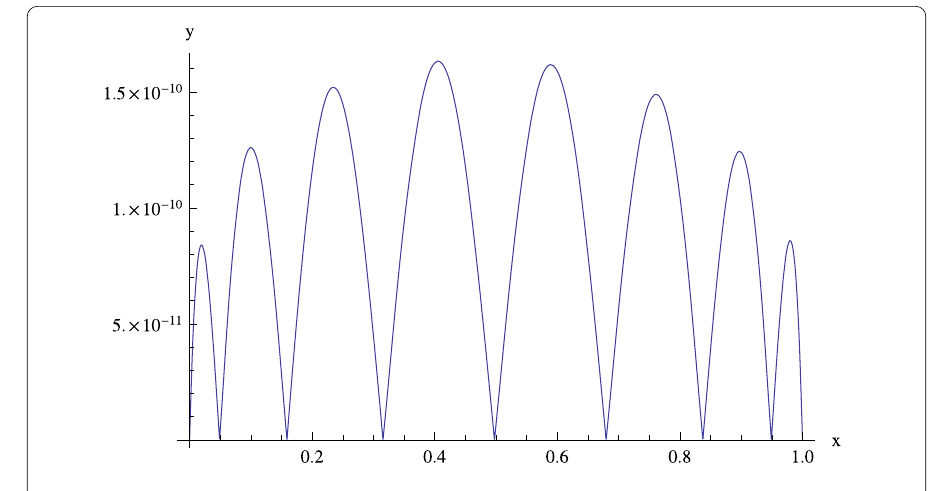
Figure 4 The absolute error curve with m =